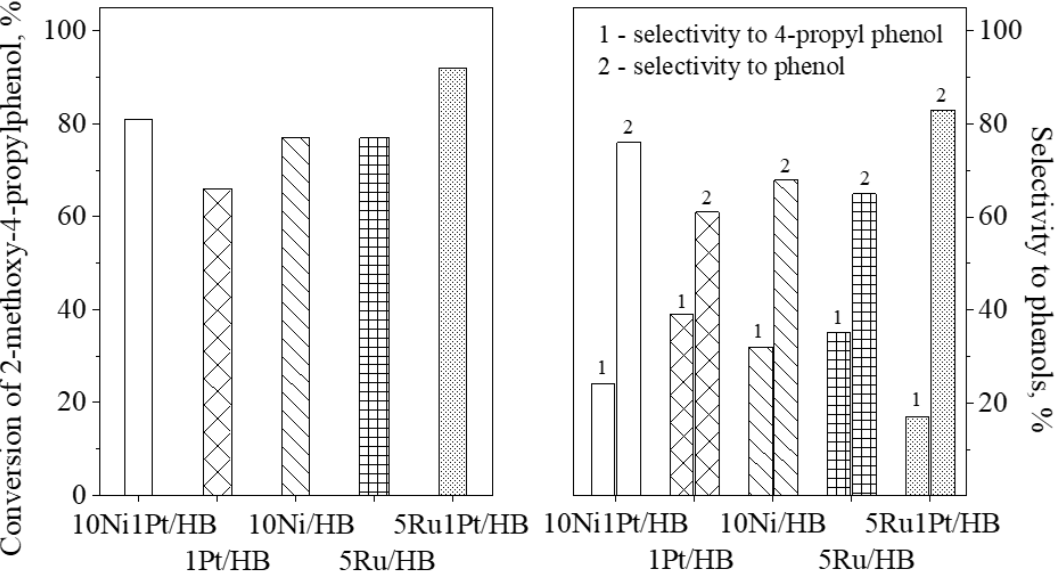
Figure 9. Catalytic activity of Ni-, Ru-, Pt-modified Beta zeolites in hydrodemethoxylation and dealkylation of 2-methoxy-4-propylphenol at 300 °C.